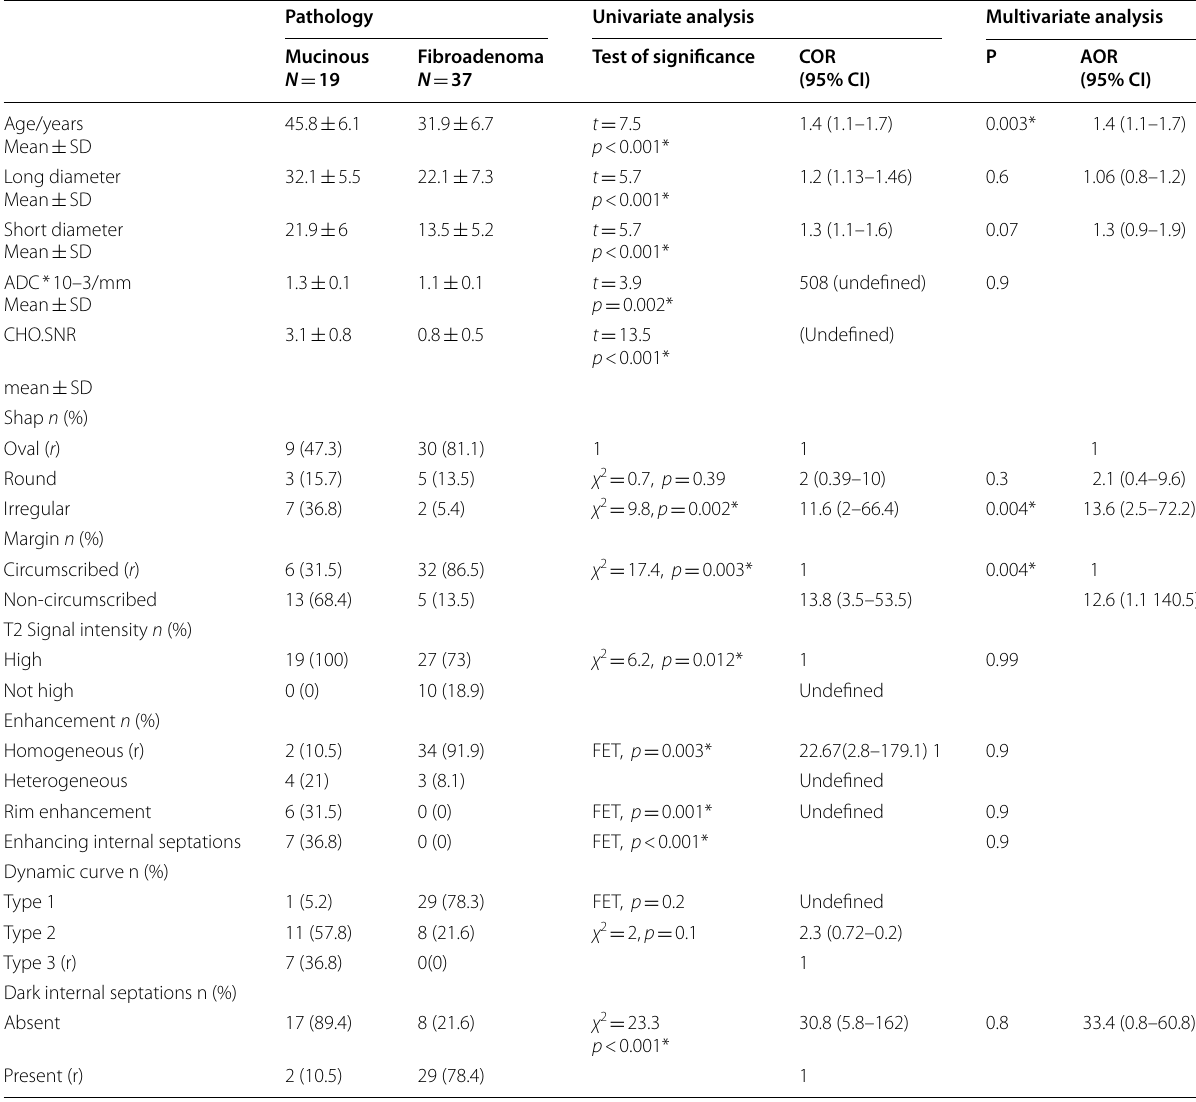
Overall % predicted